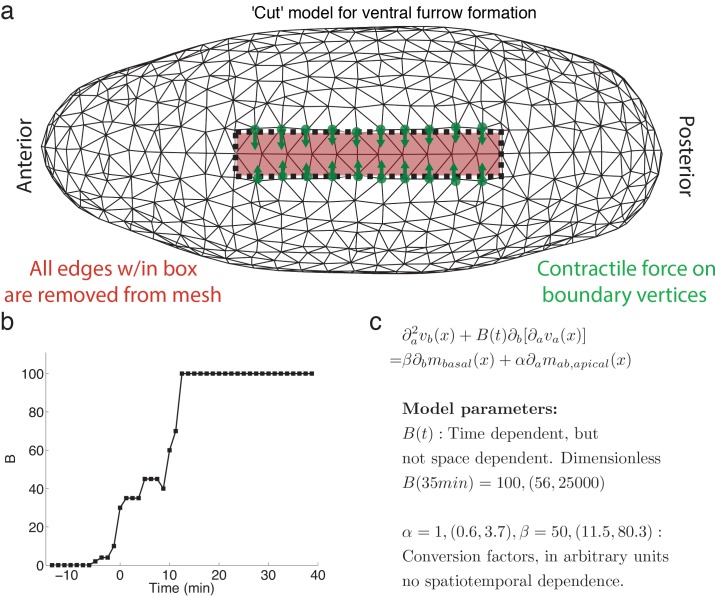
Finite element realization of model and parameter values. (a) Schematic of the finite element model including the ‘cut’ used to model ventral furrow formation. Shown is a triangulation of the embryo from a ventral perspective, anterior to the left. The ‘cut’ is realized by removing all edges within the red outlined box and introducing a contractile force(shown in green) normal to the edge as boundary condition.(b) Time dependence of B, representing ratio of viscosities (see Figure 3a for detail). (c) Model summary, with explanation of temporal dependence of model parameters. Ten percent confidence intervals are indicated in brackets.